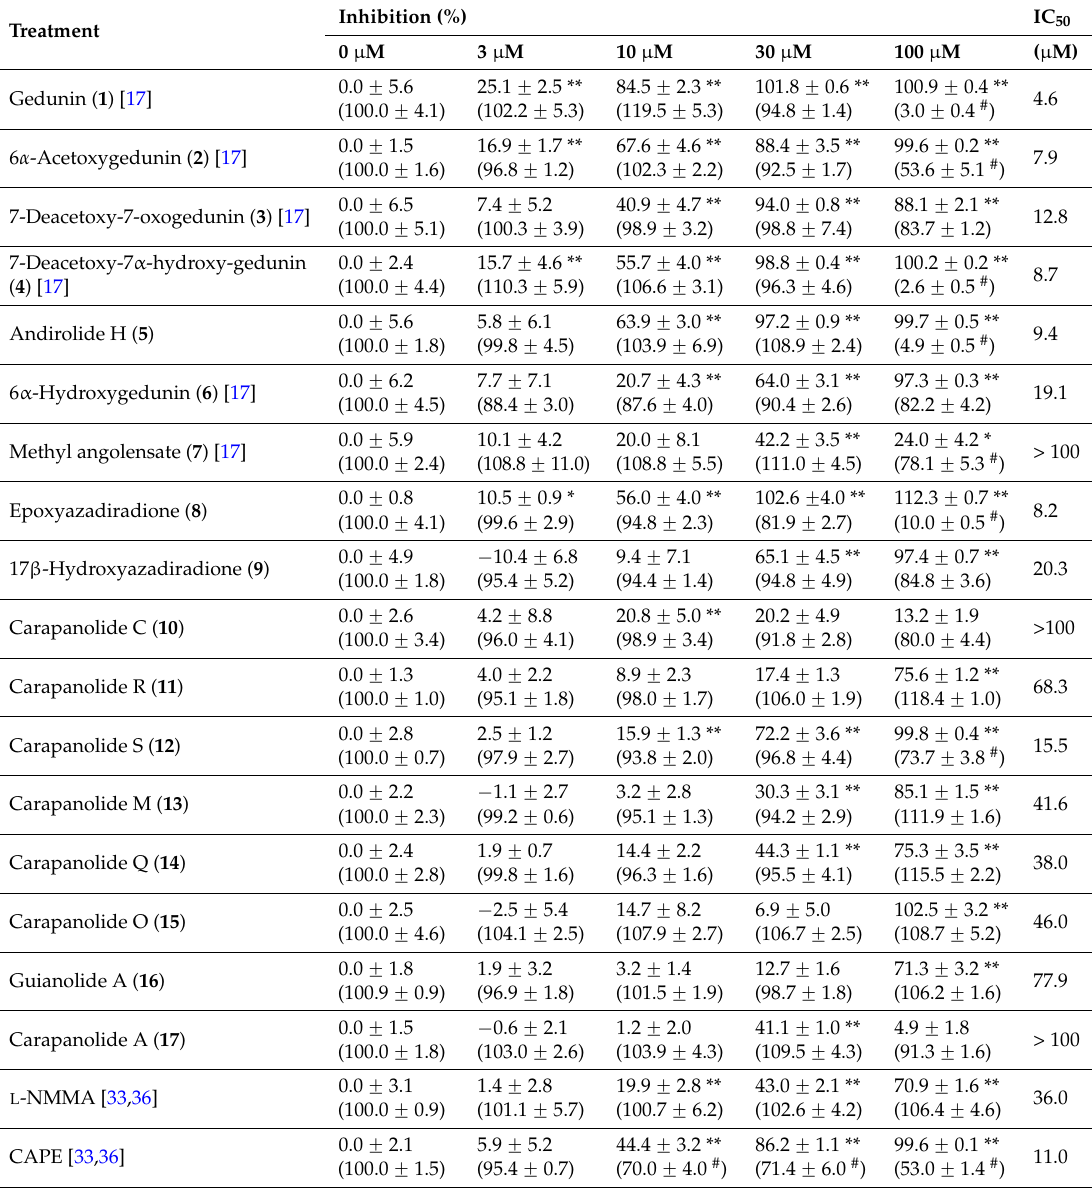
Table 3. Inhibitory effects of limonoids ( 1 – 17 ) on LPS-activated NO production in mouse peritoneal